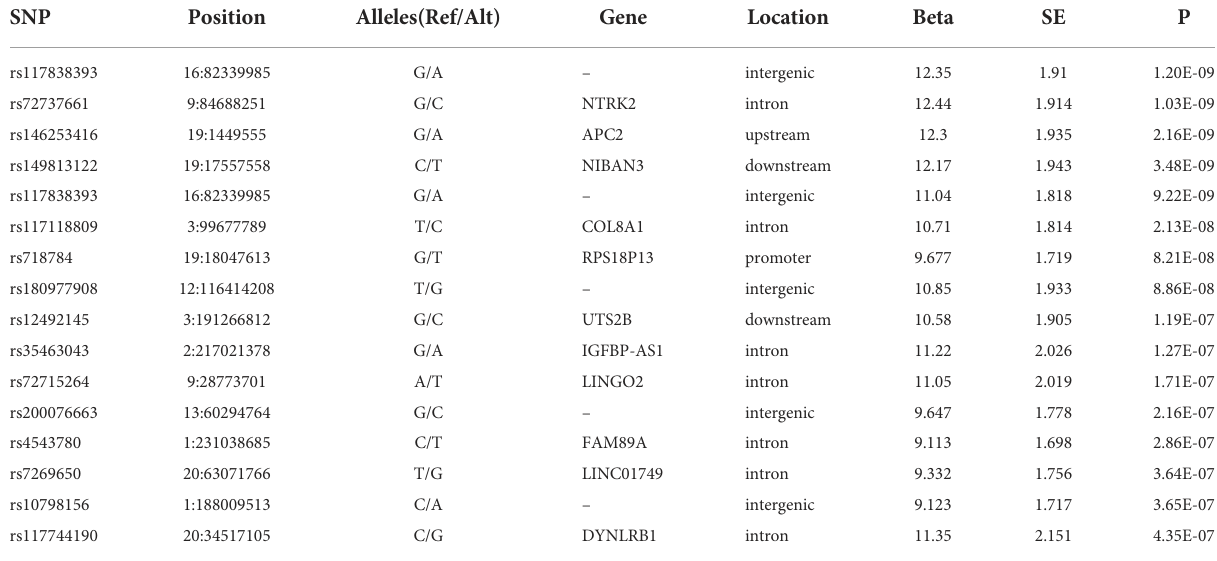
TABLE 2 Lead independent SNPs associated with Ab